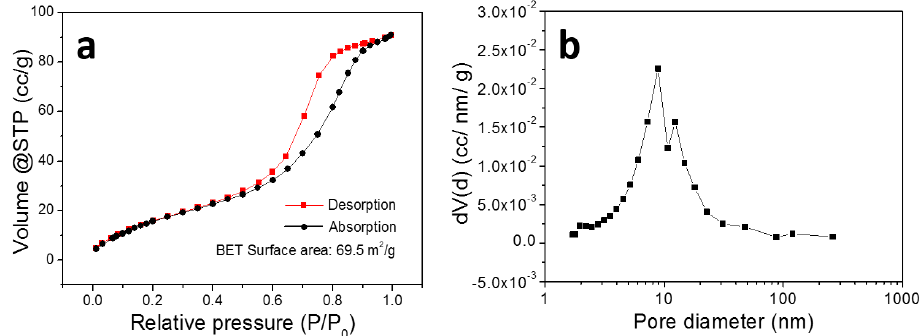
Figure 4. N 2 adsorption desorption isotherms ( a ) and corresponding BJH pore size distribution curves ( b ) of nanoporous quasi-HEA microspheres.